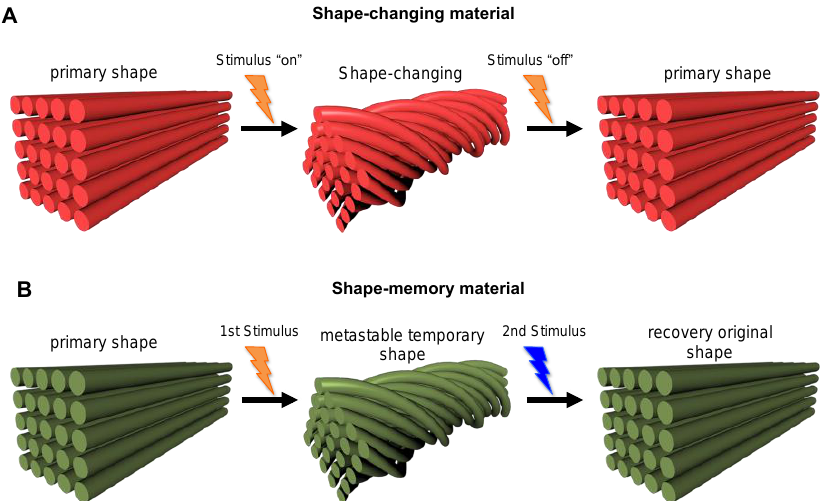
Figure 4. Illustration of ( A ) a shape-changing material with the “on-off” mechanism, and of ( B ) a shape-memory material with the two programming steps in which the structure of the material is deformed from its primary shape following the application of a stimulus and then kept in a temporary metastable shape until a second stimulus is applied allowing the recovery of the original shape.